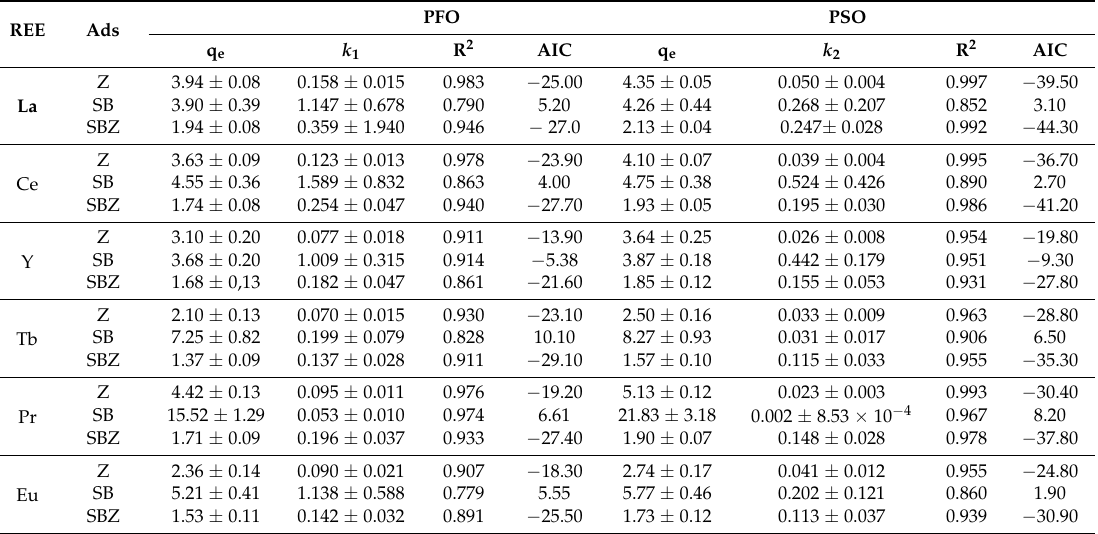
Table 7. Fitting parameters, square errors and AIC for PFO and PSO for the adsorption kinetics with the different adsorbents (Ads)—zeolite (Z), suspended biomass (SB) and supported biomass on zeolite (SBZ)—for the multi-solute assays. PFO